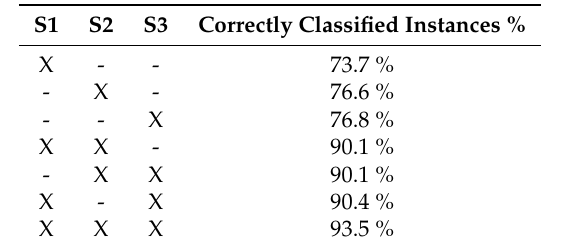
Table 2. Accuracy according to the number of sensors used (X means that the corresponding sensor was considered in the